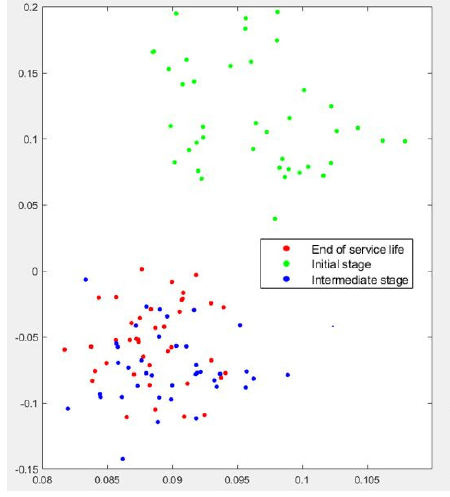
Figure 12. Graphical results of PCA analysis for Test No.3.